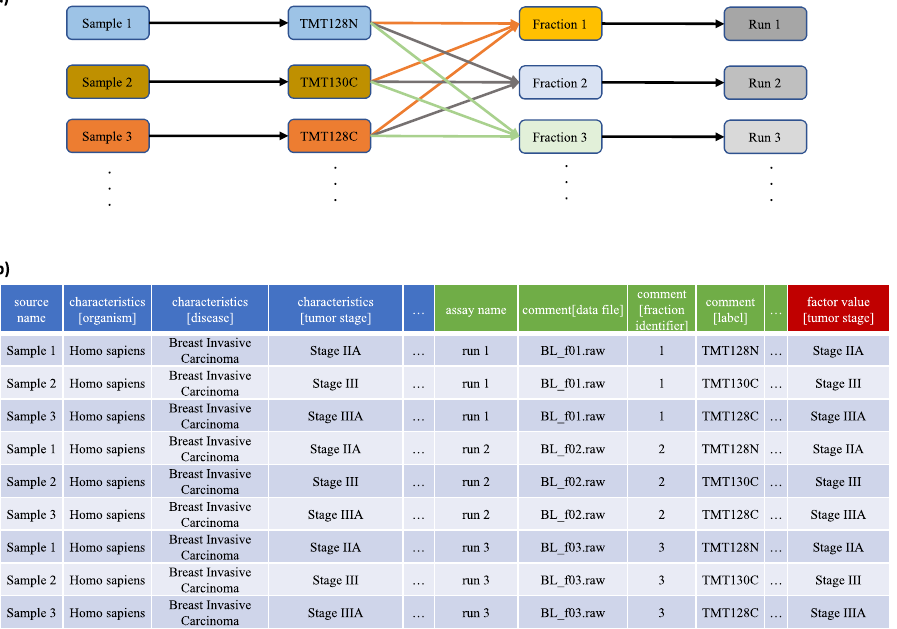
Fig. 2 SDRF-Proteomics fi le for an experiment combining TMT labeling and sample fractionation. a TMT experimental design with three samples and three fractions. b SDRF representation for a TMT experiment with three samples and three fractions resulting in nine rows where samples are repeated for each fraction and data- fi le information is repeated for each labeling channel, which is encoded using the property comment[label]